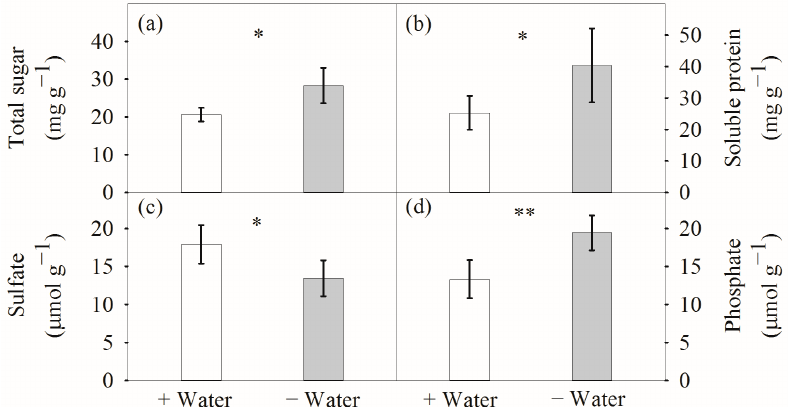
Figure 4. Leaf total sugar ( a ), soluble protein ( b ), sulfate ( c ) and phosphate contents ( d ) in leaves of Alnus glutinosa grown under sufficient (+ Water, blank bars) and limited water conditions ( − Water, grey bars). Data shown represent mean ± standard deviation ( n = 5) on a dry weight basis. Asterisks indicate significant differences between trees with sufficient and limited water supply at p < 0.05 (*) and 0.01 (**) respectively.